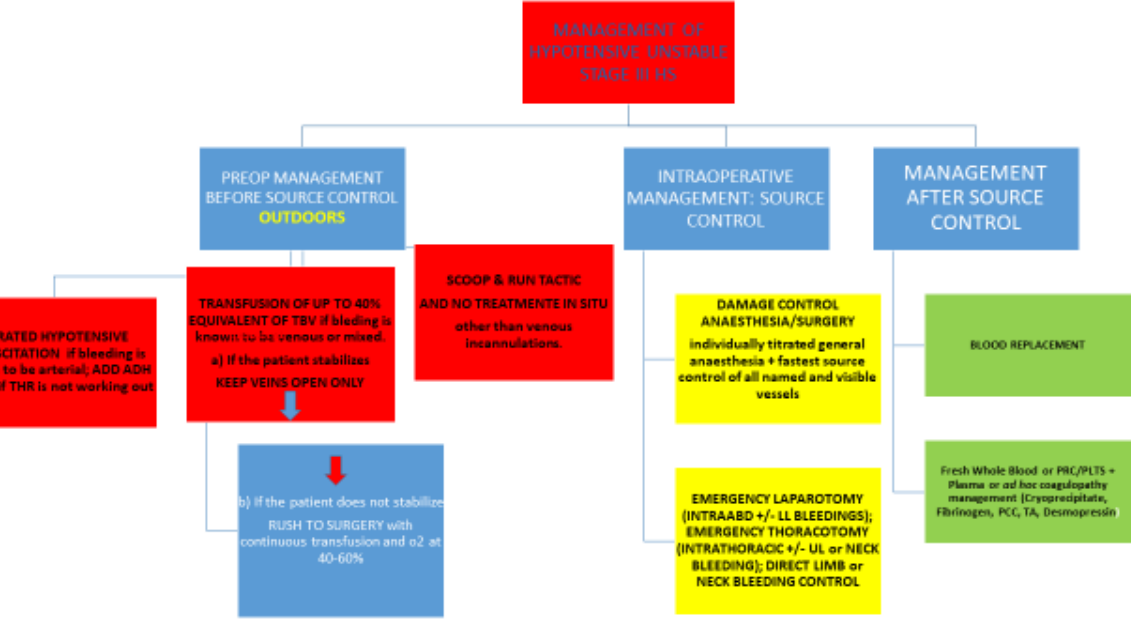
Figure 3. Management of stage III HS. TBV = total blood volume; CVL = central venous line; PRC = packed red cells; PLTS = platelets; PCC = prothrombin complex concentrates; TA = tranexamic acid; HR = hypotensive resuscitation; ADH = anti-diuretic hormone; NA = noradrenaline; LL = lower limbs; UL = upper limbs.